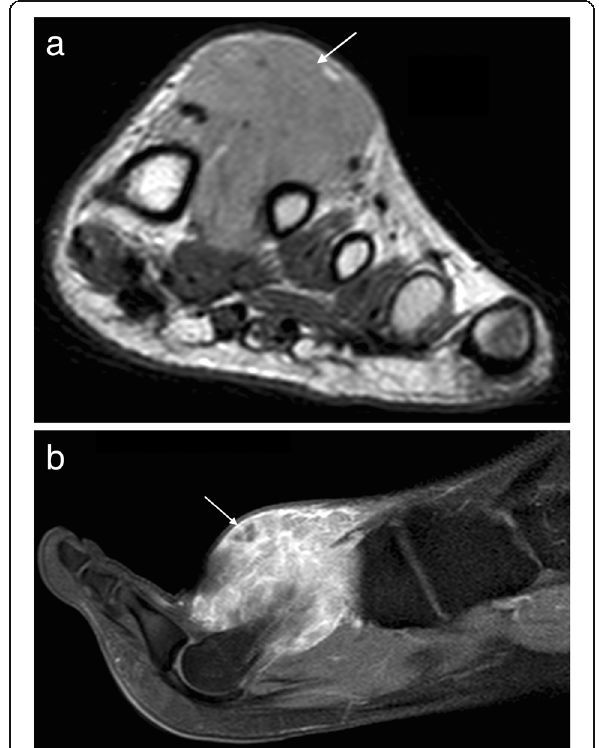
Fig. 12 Rhabdomyosarcoma. Short axis T1 image ( a ) of the foot of a 14-year-old girl demonstrating a hyperintense mass in the first web- space with avid enhancement on postcontrast T1FS imaging ( b